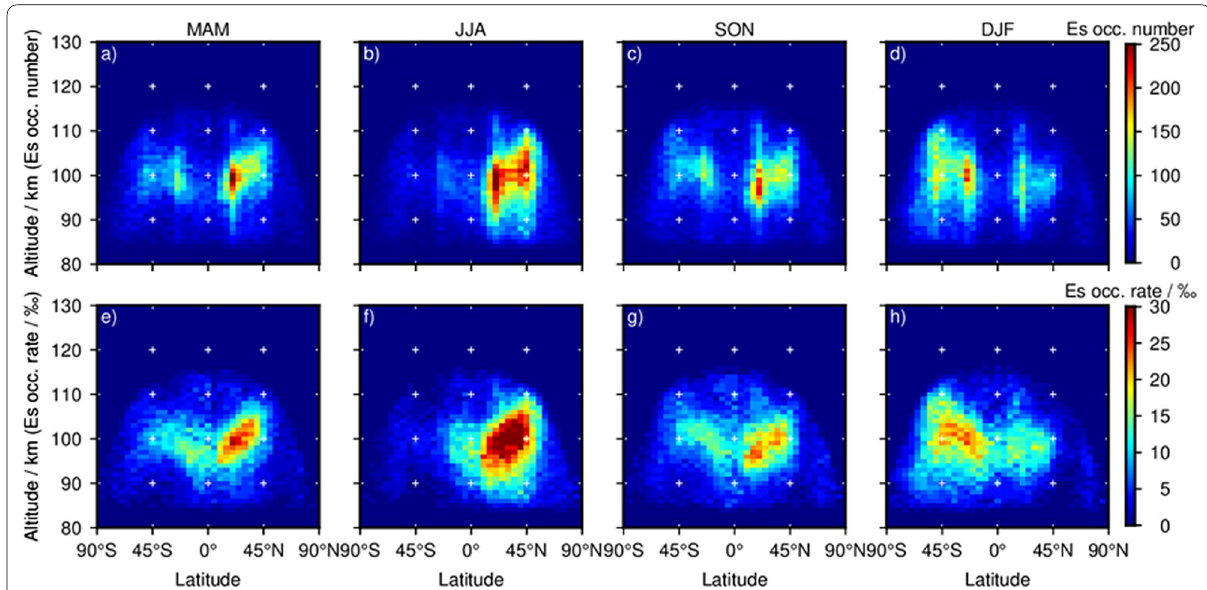
Fig. 6 Seasonal variation in the altitude–latitude distributions of FY-3C RO-derived Es occurrence numbers (upper panels) and Es occurrence rates (lower panels) during Jan. 2015 to Dec. 2019, with a resolution of 1 km d , h DJF